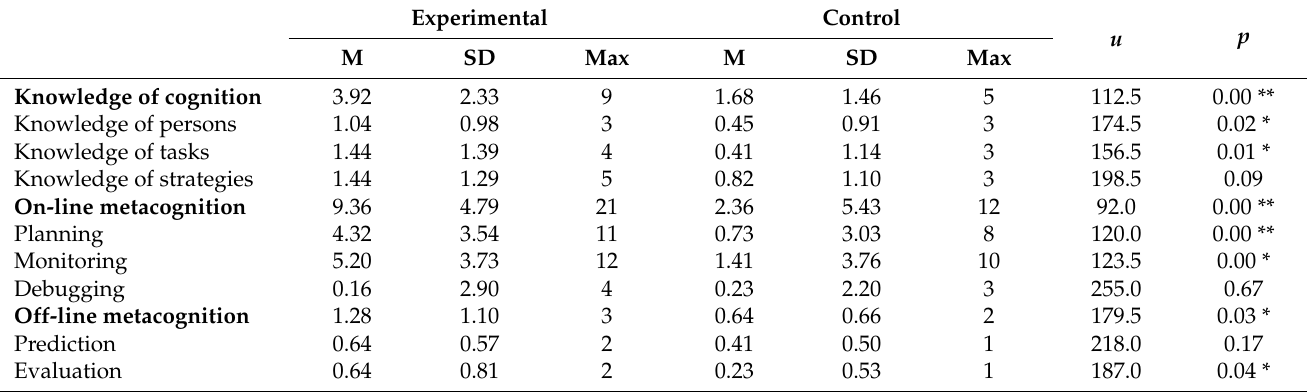
Table 5. The means (standard deviations) of the gain scores and Mann–Whitney test